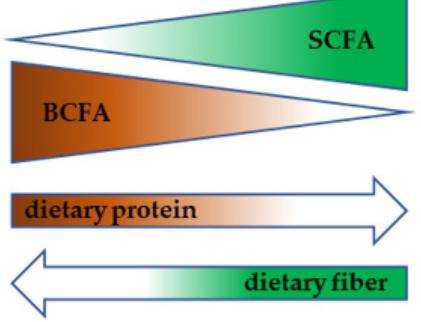
Figure 4. Diet-dependent metabolic switch in gut microbiota.